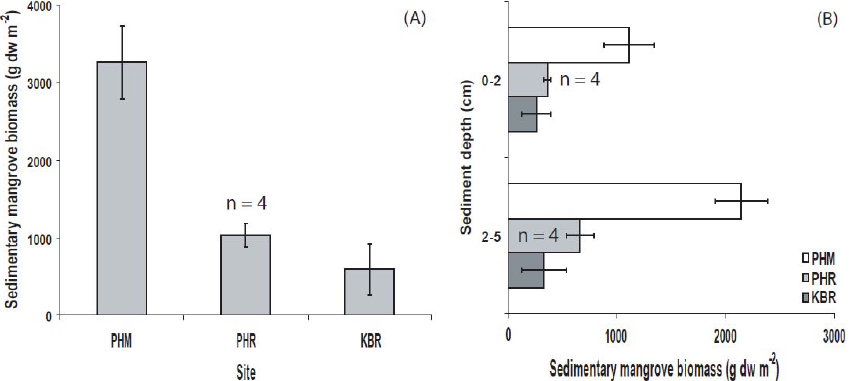
Fig. 2. Total sedimentary mangrove biomass (A) and vertical distribution of sedimentary mangrove biomass (B) within cores from the PHM, PHR and KBR sites. Bars denote mean ± 1SE ( n = 3), unless otherwise